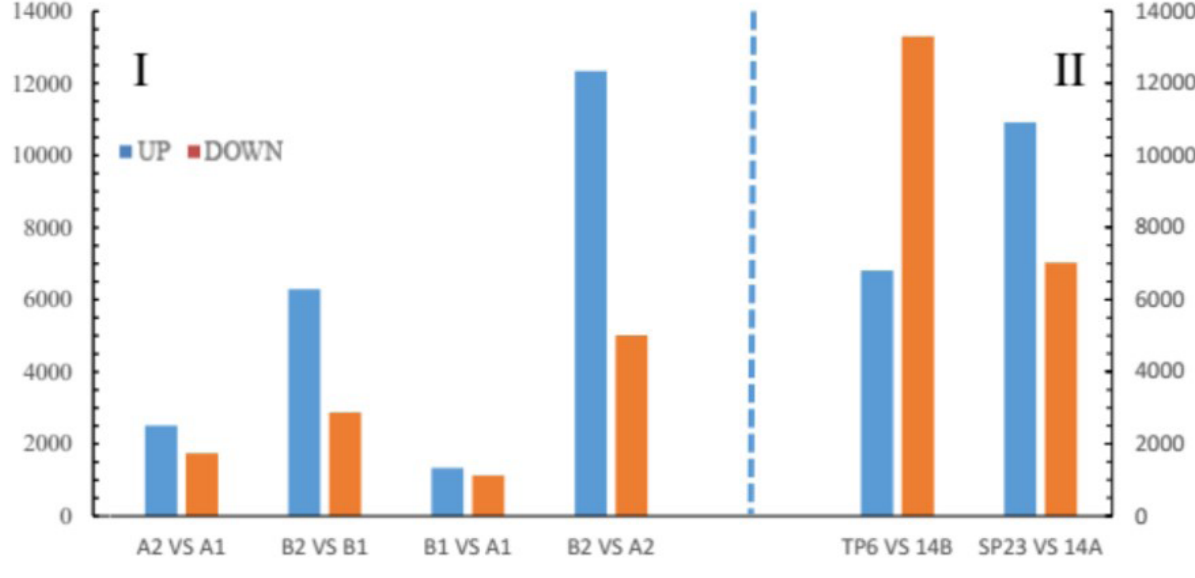
Figure 4 ‒ Differentially expressed genes